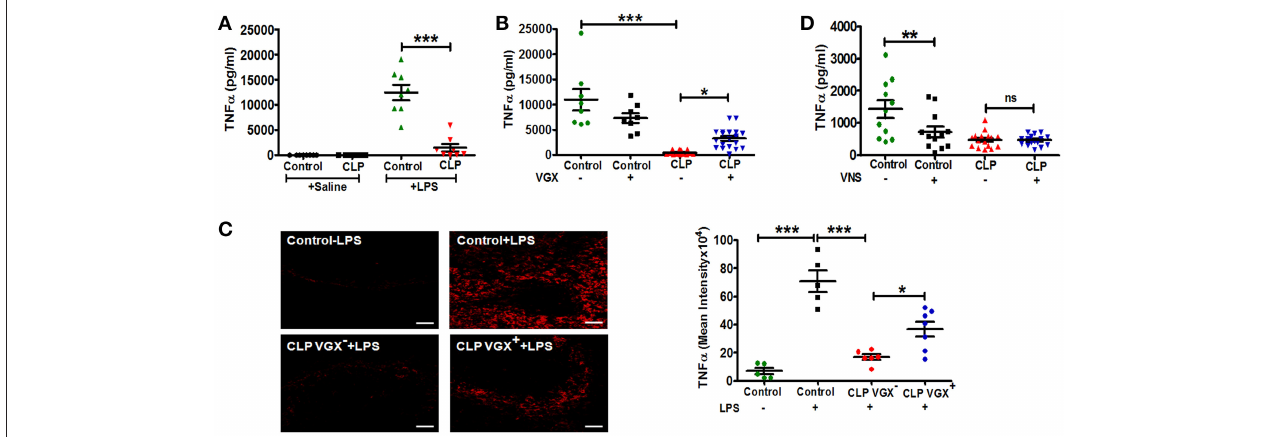
FIGURE 1 | Vagotomy restores LPS-induced TNF α response in CLP-survivors. To assess the in vivo immune response of CLP-surviving mice to subsequent LPS challenge, BALB/c mice were subjected to control or CLP surgery, allowed to recover for 4 weeks, and then administered LPS (4 mg/kg) by intraperitoneal injection. Vagotomy (VGX) was performed 2 weeks post-CLP or control surgery. Blood and spleens were harvested 90min after LPS administration. (A) Lower TNF α levels in serum of sepsis survivors in response to LPS challenge in vivo . ( n = 8 mice/group). Results are the mean ± SEM from two independent experiments, Control + LPS vs. CLP + LPS *** p < 0.001 (Tukey’s post hoc test). (B) Restoration of LPS-induced TNF α responses following bilateral subdiaphragmatic vagotomy in sepsis survivors. ( n = 8–19 mice/group). Results are the mean ± SEM from three independent experiments, CLP VGX − vs. CLP VGX + * p < 0.05 and Control VGX − vs.